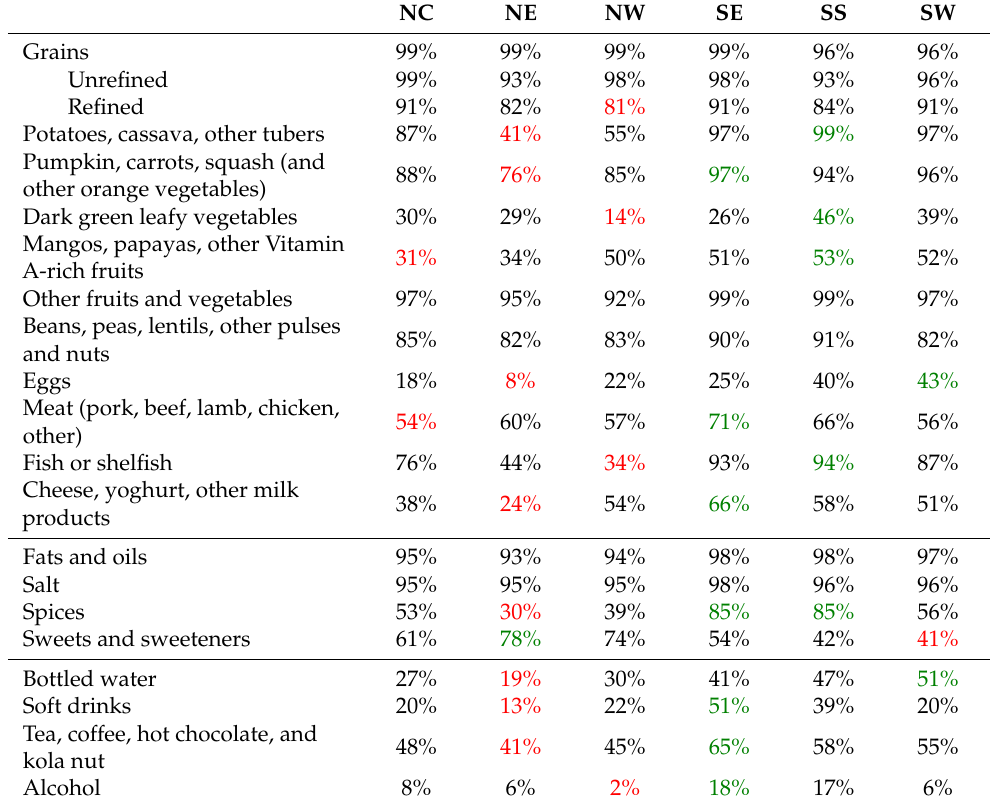
Lowest numbers for regions are highlighted in red, the highest are in